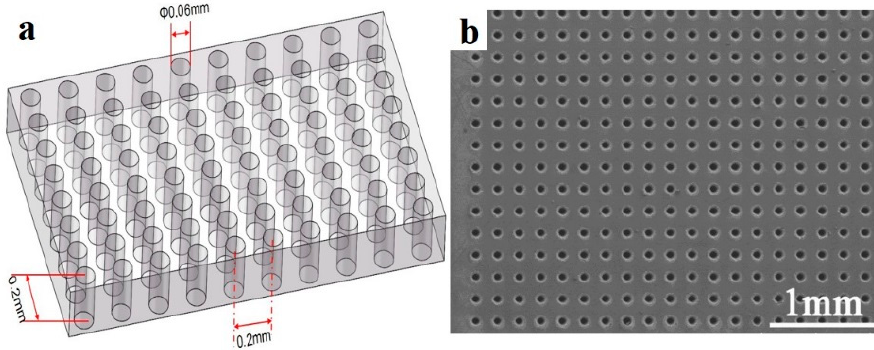
Figure 5. ( a ) Schematic and ( b ) SEM image of the multi-channel glass template.